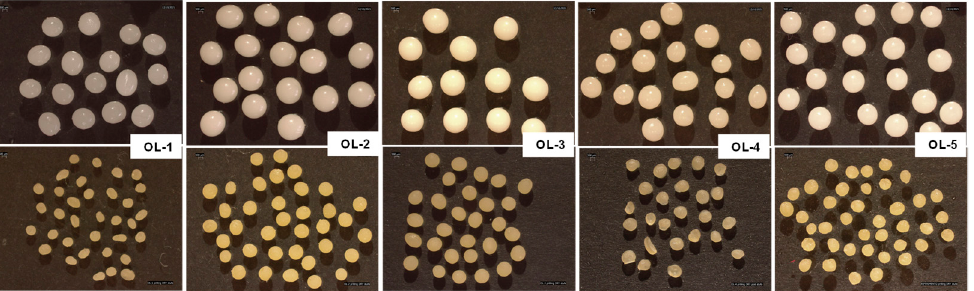
Figure 2. Stereomicroscope images of wet ( fi rst line) and dried (second line) placebo microparticles.